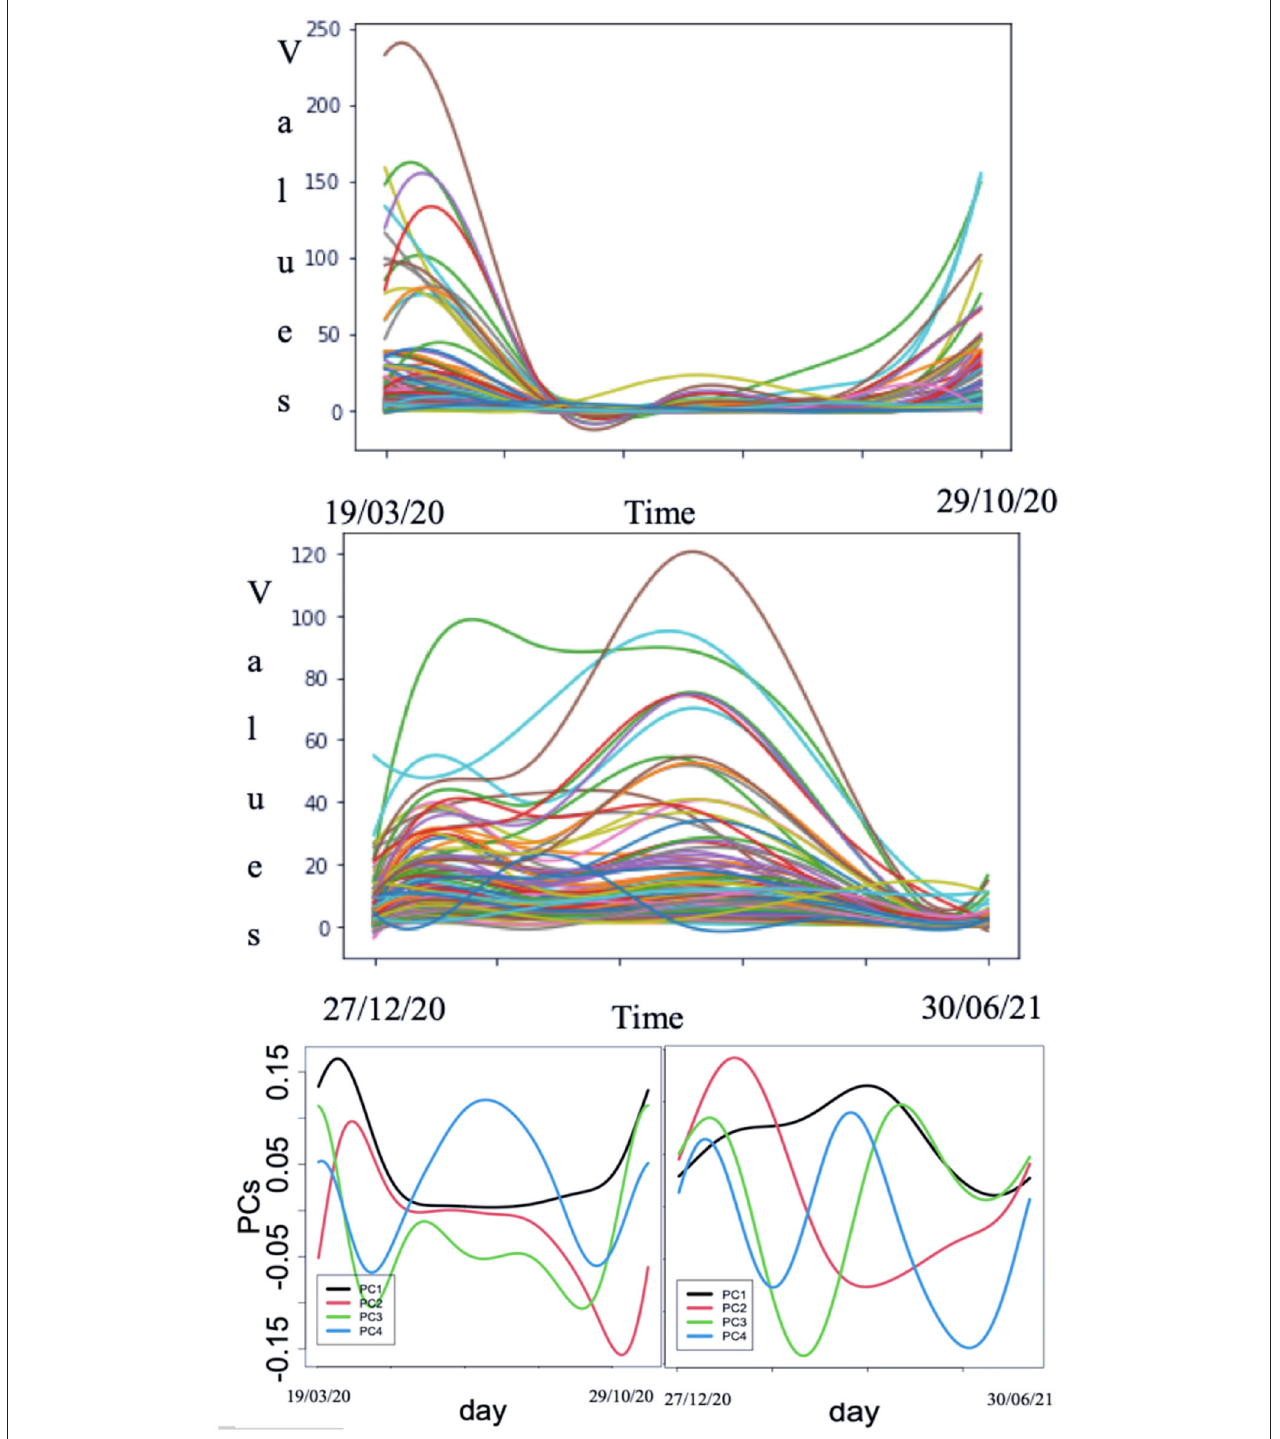
FIGURE 8 | Smoothed curves for coronavirus disease 2019 (COVID-19) hospitalization cases in all the departments in France before (top) and after (middle) vaccination. Bottom: Functional principal components (PCs) for the above hospitalization case curves (after [35]).